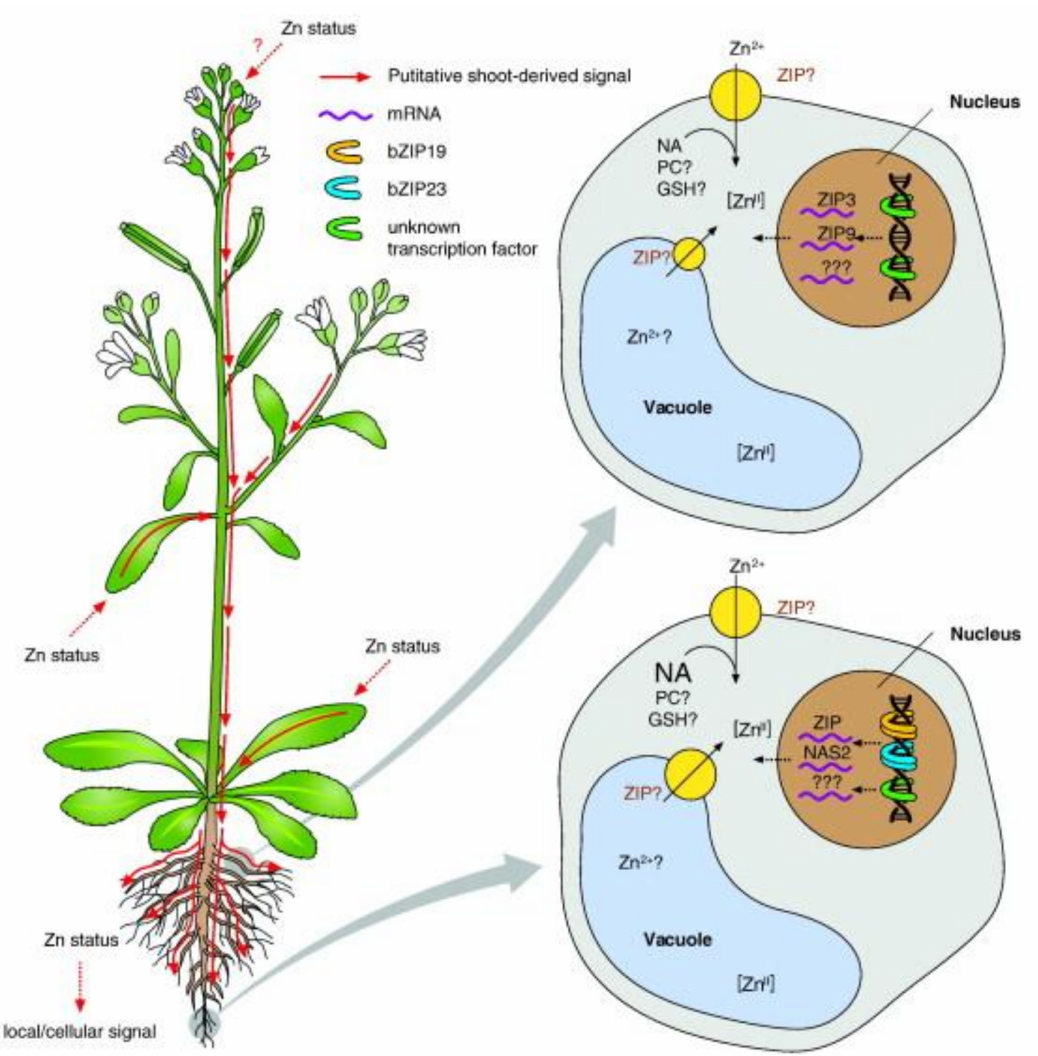
Figure 3. Potential signaling of Zn deficiency. Shown is a hypothetical model of proposed systemic (upper left and upper right) and local (lower left and lower right) responses to Zn deficiency in root cells. Increases in ZIP3 and ZIP9 transcript levels were observed in roots when NgMTP1 was overexpressed in shoots (hypothesized to generate shoot-specific physiological Zn deficiency). This supports the existence of a putative systemic Zn-deficiency signal originating from the shoot that triggers Zn deficiency response gene expression in the root through unknown regulators. Local Zn deficiency results in the activation of bZIP19 and bZIP23 , which activate the transcription of a number of ZIP and NAS genes. Additional regulators may mediate further components of the Zn deficiency response. See main manuscript text for a detailed discussion